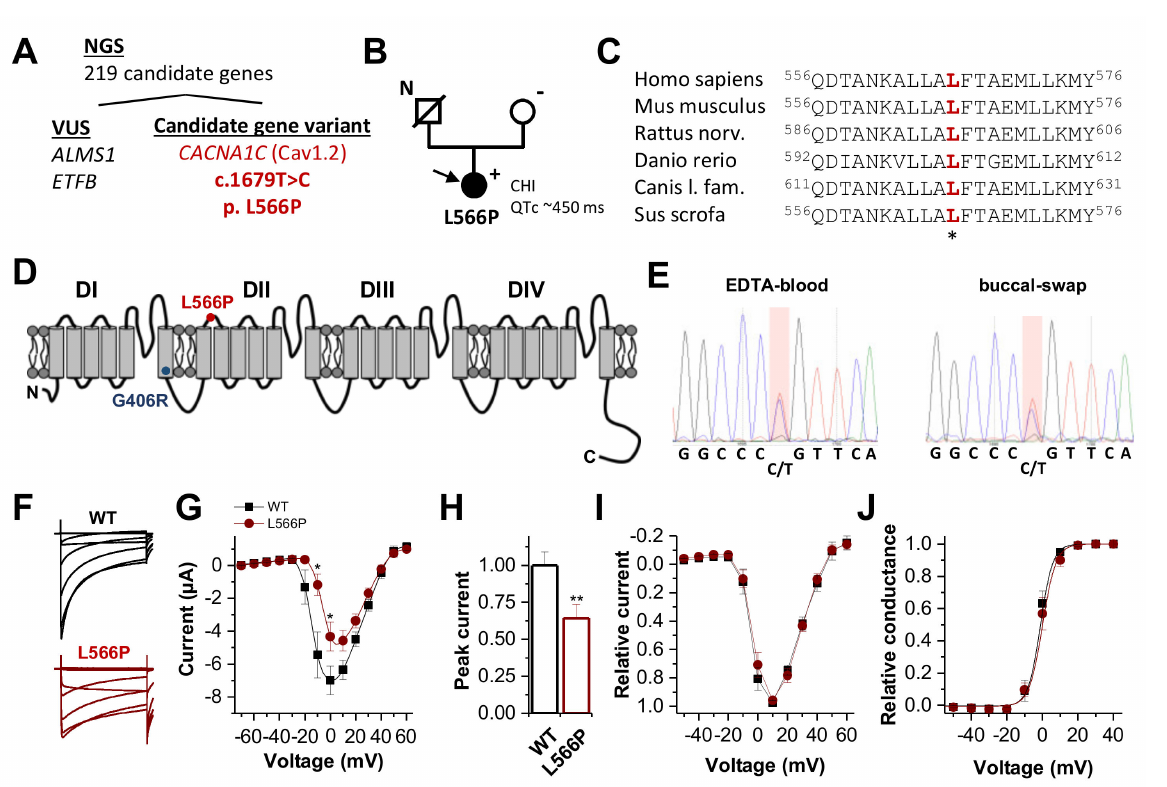
Figure 1. Ca V 1.2 channel topology, localization and conservation of the Ca V 1.2 L566P mutation iden- tified by WES and electrophysiological characterization. ( A ) NGS panel sequencing of 219 genes associated with familial hyperinsulinism or related disorders of the glucose metabolism variants fil- tered out four variants of uncertain significance (VUS) and one candidate gene variant in CACNA1C. ( B ) Pedigree of the family. N, no genomic data available; +, heterozygous carrier of c.1679T > C; − , absence of the variant. The filled circle and arrow indicate the diseased index patient. CHI, congenital hyperinsulinism. ( C ) Partial amino acid sequence alignment of Ca V 1.2, illustrating the conservation of the respective leucine residues among the different orthologues. ( D ) Ca V 1.2 channel topology. DI to DIV indicate the four calcium channel domains, each consisting of six transmembrane segments and one pore-forming domain. The localization of the channel variants Ca V 1.2 L566P and Ca V 1.2 G406R is indicated as red and blue dots, respectively. ( E ) Electropherogram of the mutation carrier confirming the CACNA1C variant by Sanger sequencing of DNA isolated from EDTA blood and buccal swabs of the patient. ( F ) Representative current traces of Ca V 1.2 WT (black) and Ca V 1.2 L566P (red) recorded from a holding potential of − 80 mV, with voltage steps of 1 s duration ranging from − 70 to +60 mV in 10 mV increments. The interval between the steps was 30 s. ( G ) Current–voltage relationship of wild-type Ca V 1.2 (black) ( n = 19) and Ca V 1.2 L566P (red) ( n = 14) channels recorded from three independent batches of oocytes. ( H ) Analysis of the relative peak current amplitudes normalized to wild-type Ca V 1.2. ( I ) Relative current–voltage relationships of wild-type Ca V 1.2 (black) ( n = 10) and Ca V 1.2 L566P (red) ( n = 10) normalized to the peak current. In this analysis, only recordings with peak current amplitudes <5 µ A were considered. ( J ) Conductance–voltage relationship of Ca V 1.2 WT and Ca V 1.2 L566P (red). **, p < 0.01; *, p <